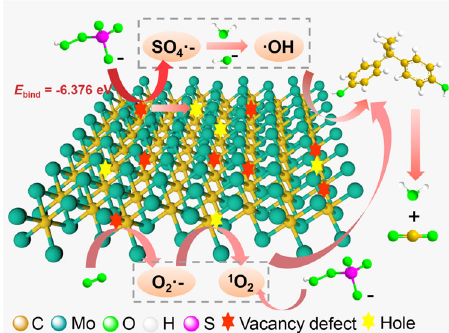
Fig. 7 The degradation mechanism. Proposed mechanism of Mo 2 C MXene activating peroxymonosulfate (PMS) for the degradation of bisphenol A (BPA).